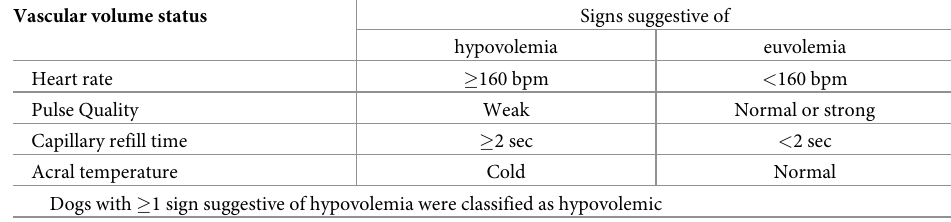
Hydration status Signs suggestive of dehydration euhydration overhydration Skin turgor Reduced Normal Gelatinous Eyes Sunken Normal Peripheral edema Absent Present